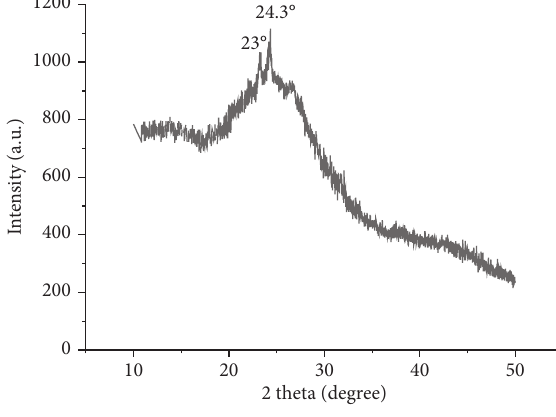
Figure 2: XRD analysis of